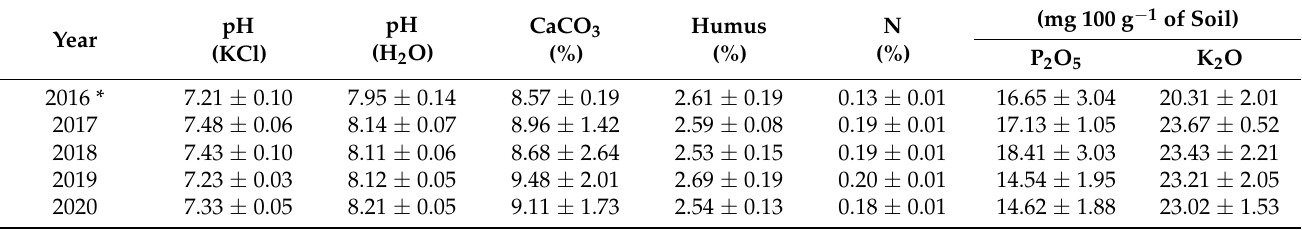
Table 2. Average soil chemical characteristics of experimental site after maize crop